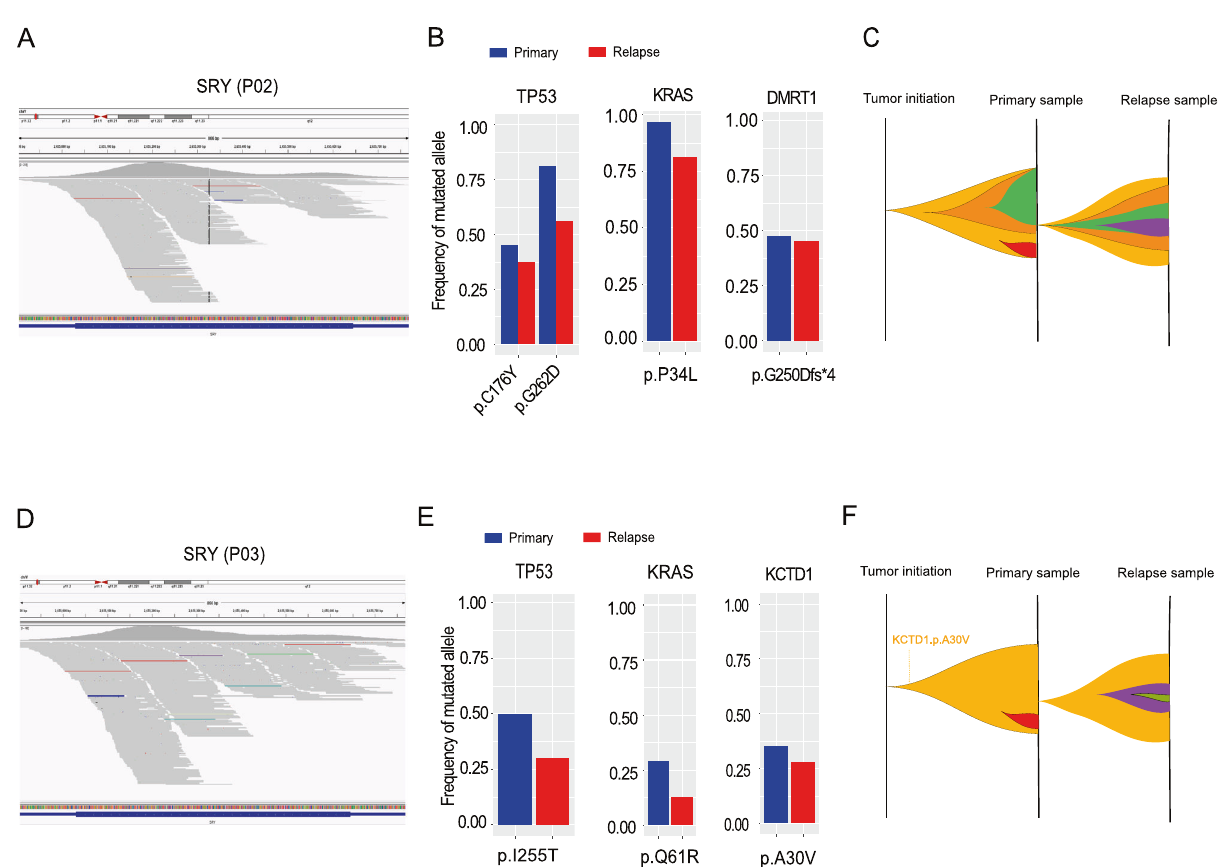
Fig. 4 Key drivers and clonal evolution of YST patients with abnormal gonad development. The whole-exome sequencing reads mapped to sex- determining region Y protein, SRY, from Y chromosome in the primary tumor sample of patients P02 ( A ), and P03 ( D ). The allele frequencies of TP53, KRAS , DMRT1 , and KCTD1 in primary and relapse samples from P02 ( B ), and P03 ( E ). The raw allele frequency was calculated based on the proportion of the reads containing the altered allele among all the reads mapped to that position. A schematic representation of the putative clonal evolution of YSTs in the patients, P02 ( C ), and P03 ( F ). Subclones are shown in different